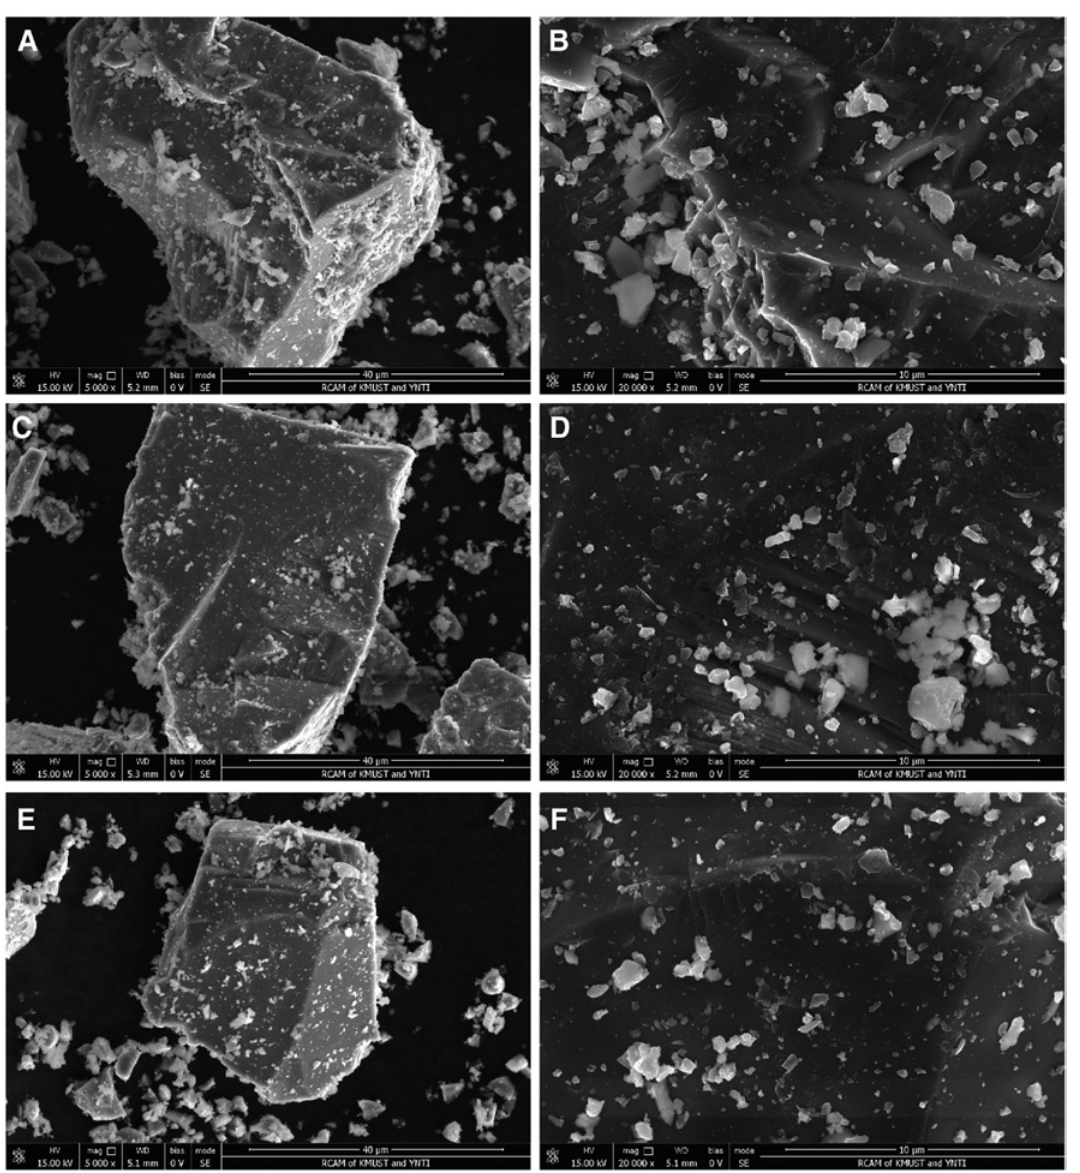
Figure 5: Scanning electron microscopy (SEM) of high titanium slag before and after microwave drying. (A), (B) raw materials; (C), (D) micro- wave dried 50 s; (E), (F) microwave dried 90